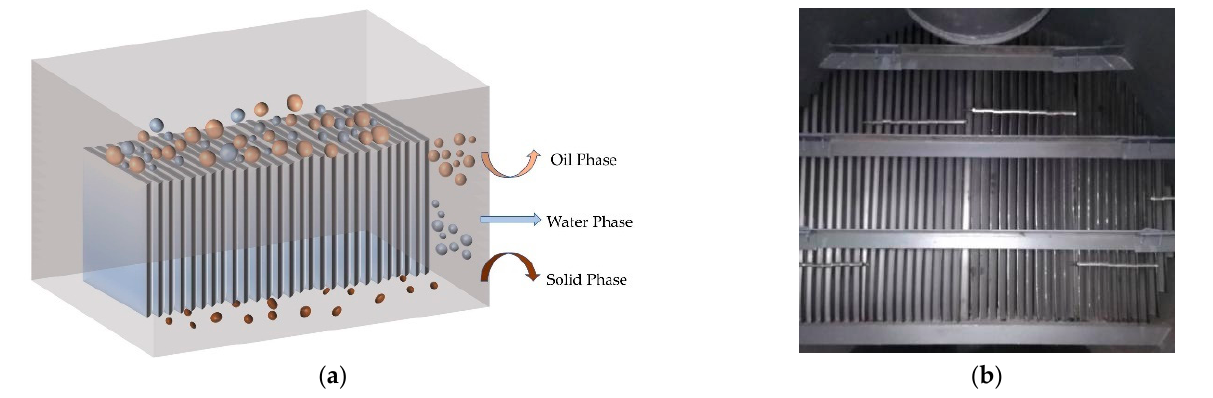
Figure 5. ( a ) Theoretical model diagram of coalescent packing assembly; ( b ) the actual appearance of coalescent packing assembly.